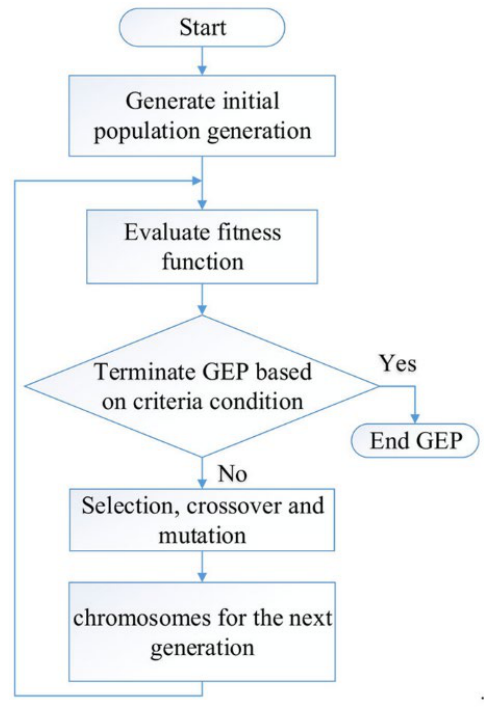
Figure 1. Flowchart of GEP model.